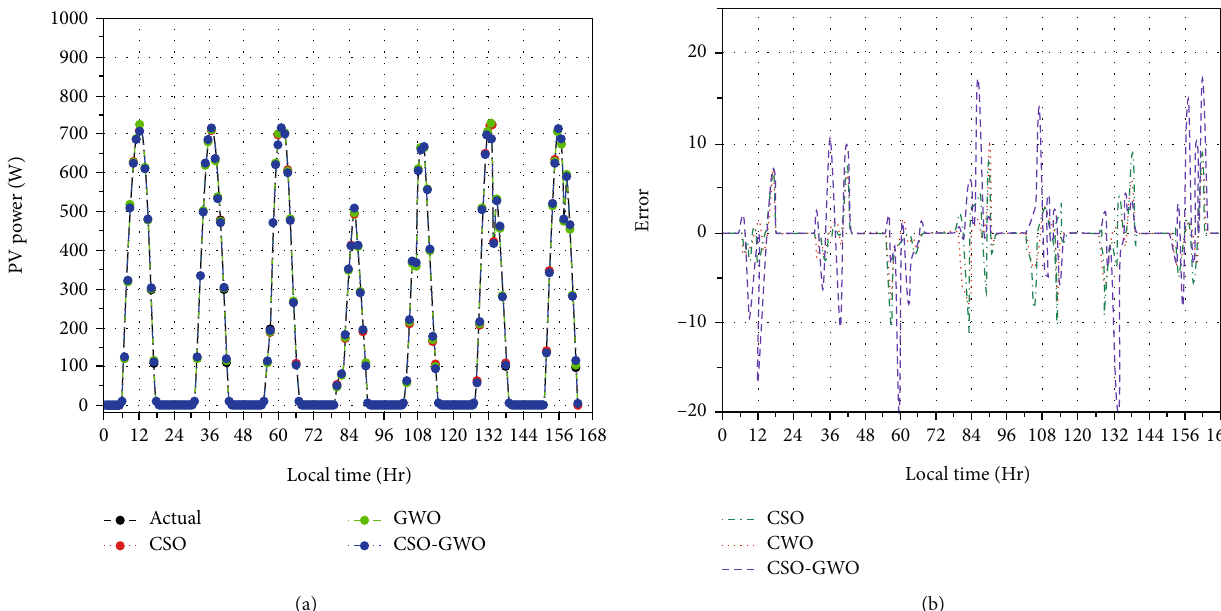
Figure 6: (a) daily output power prediction of the PV system (b) error